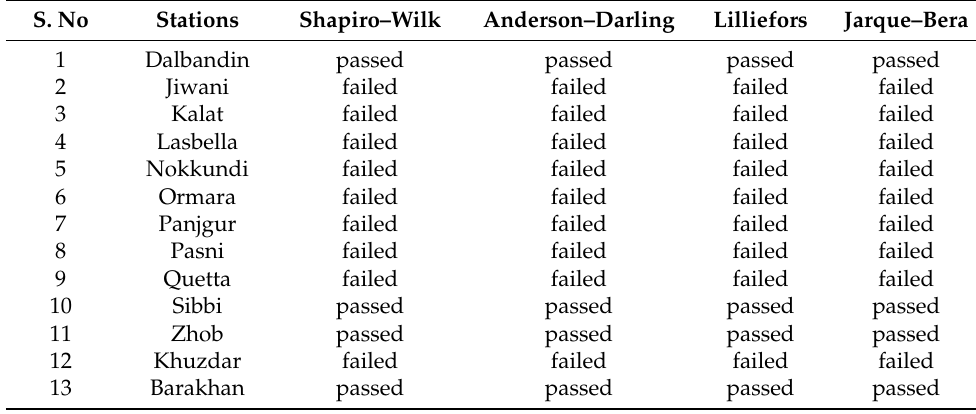
Table A2. Normality tests on the annual time